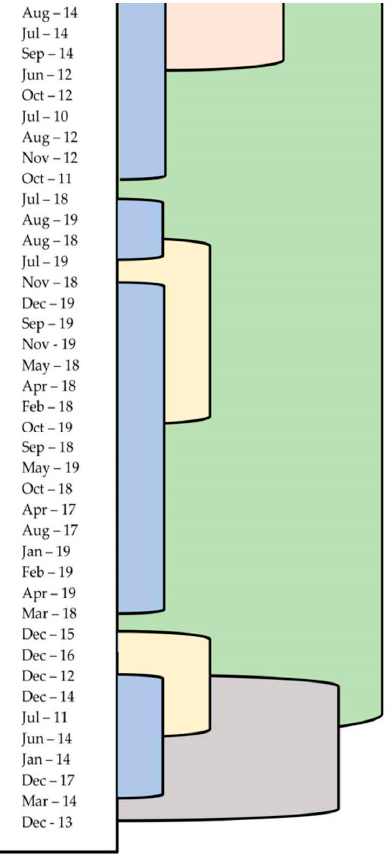
Figure 4. Tourist arrivals dendrogram using average linkage (between groups). Table 2. Clusters descriptive statistics of five financial news